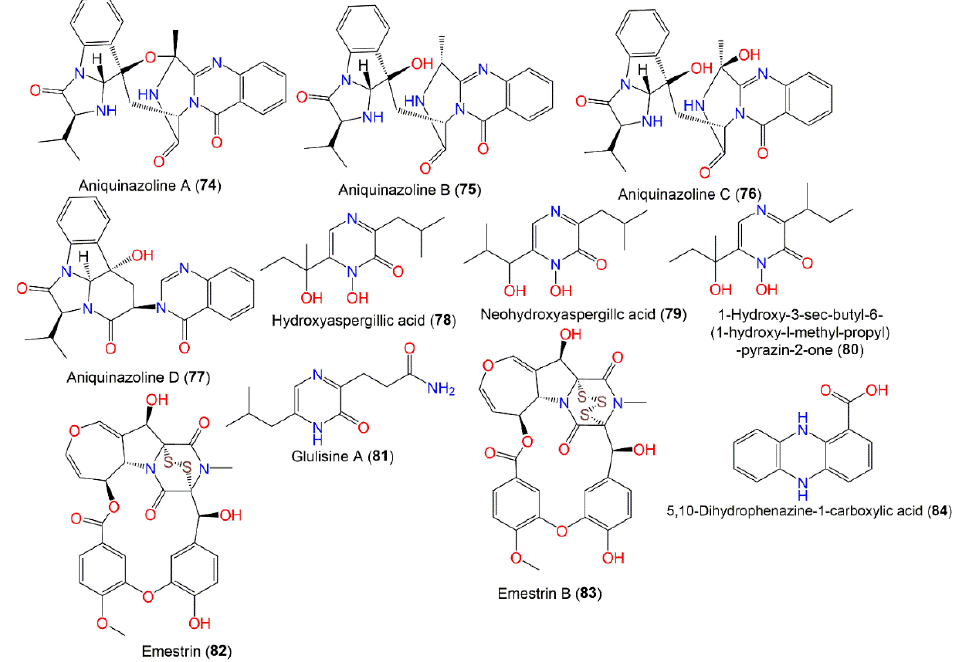
Figure 7. Structures of quinazolinone ( 74 – 77 ), pyrazine ( 78 – 81 ), dioxopiperazine ( 82 and 83 ), and phenazine ( 84 ) alkaloids.